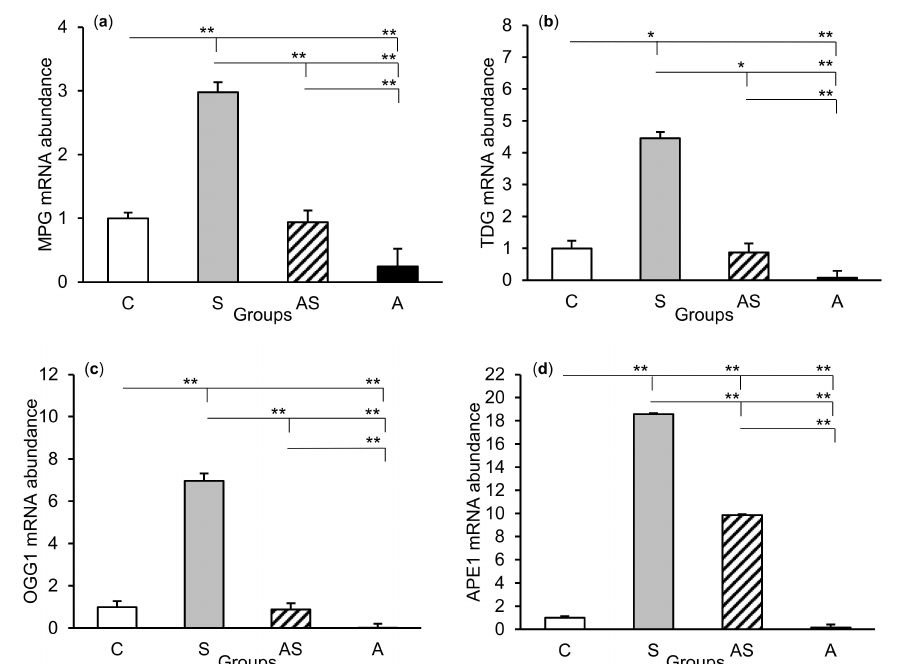
Figure 3. Relative mRNA abundance (mean ± SEM) of N-methylpurine-DNA glycosylase (MPG), ( a ) thymine-DNA glycosylase (TDG), ( b ) 8-oxoguanine glycosylase (OGG1), ( c ) and AP-endonuclease 1 (APE1), ( d ) in the hippocampal CA3 field of sheep treated with: vehicle (C), vehicle and stressful stimuli (S), allopregnanolone and stressful stimuli (AS), and allopregnanolone alone (A). Significance of di ff erences: * p < 0.05, ** p <